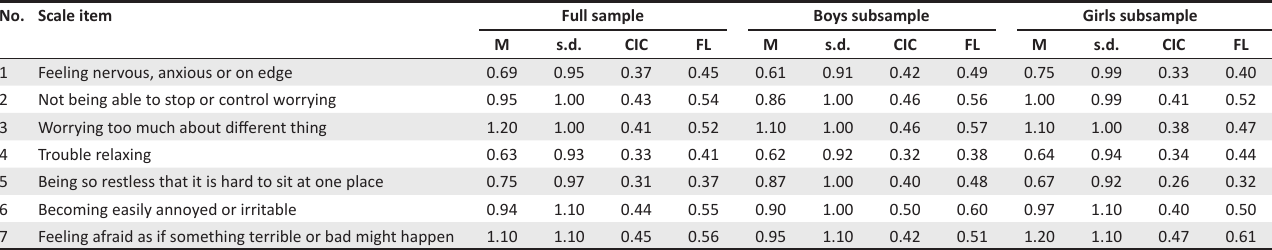
TABLE 2: Characteristics of Generalised Anxiety Disorder-7 scale items (boys = 231, girls = 322). No. Scale